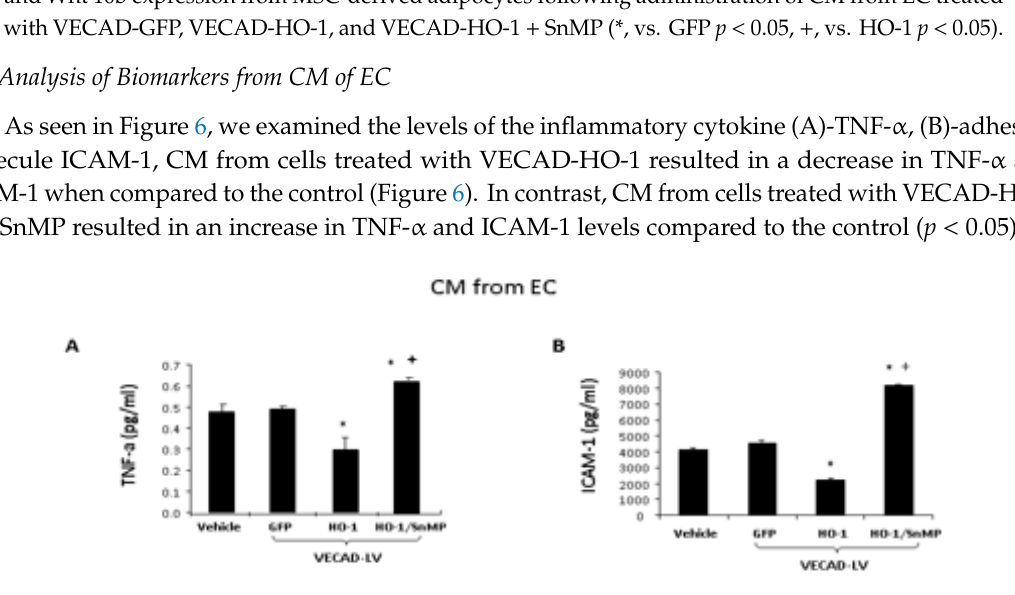
Figure 6. ( A , B ) Cytokine array analysis of TNF- α and ICAM-1 following treatment of HMEC-1 with VECAD-GFP, VECAD-HO-1, and VECAD-HO-1 + SnMP (* vs GFP p < 0.05, + vs HO-1 p <